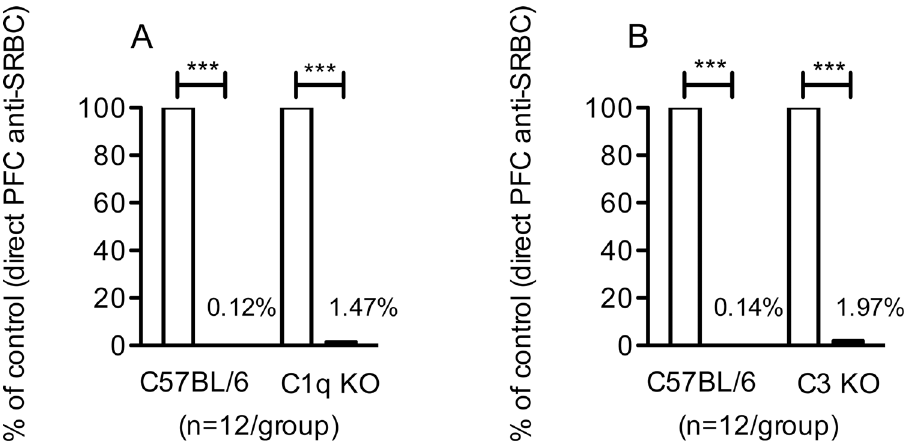
Fig 1. IgG-mediated suppression of primary IgM-responses in C1q KO and C3 KO mice. C1q KO, C3 KO, and C57BL/6 mice were immunized with 50 μ g IgG a anti-SRBC and 5x10 7 SRBC, 5x10 7 SRBC alone, or with 50 μ g IgG a alone. (A,B) Five days after immunization, the number of spleen cells producing IgM anti- SRBC was assayed. Responses are shown as percentage of the direct PFC response/spleen in mice given SRBC alone (100%, open bars); black bars show responses in mice given IgG and SRBC. Direct PFC/spleen in the respective control groups (receiving antigen alone) were in A: C57BL/6, 56,105; C1q KO, 5,433 and in B: C57BL/6, 54,954; C3 KO, 3,614. Data are pooled from three experiments; (n = 4/group in each experiment). p-values denote comparisons between mice immunized with IgG anti-SRBC together with SRBC and mice immunized with SRBC alone. *** , p <